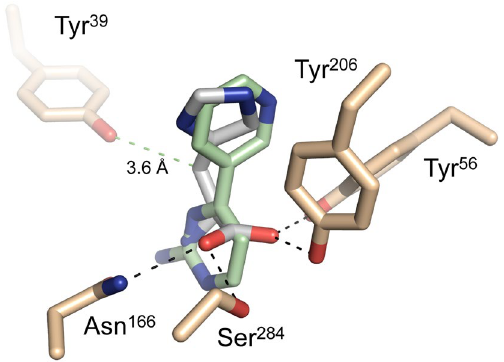
Figure 10. Superposition of M. tb EgtD-Imatinib (green) and EgtD-L-Histidine (gray) structures. Highlighted are the interaction differences between the L-Histidine and Imatinib structures. In the L-Histidine complex Tyr 56 , Tyr 206 , Ser 284 , and Asn 166 of EgtD. Tyr 39 forms a van der Waals interaction with the α-carbon of L-Histidine that is lacking in the Imatinib